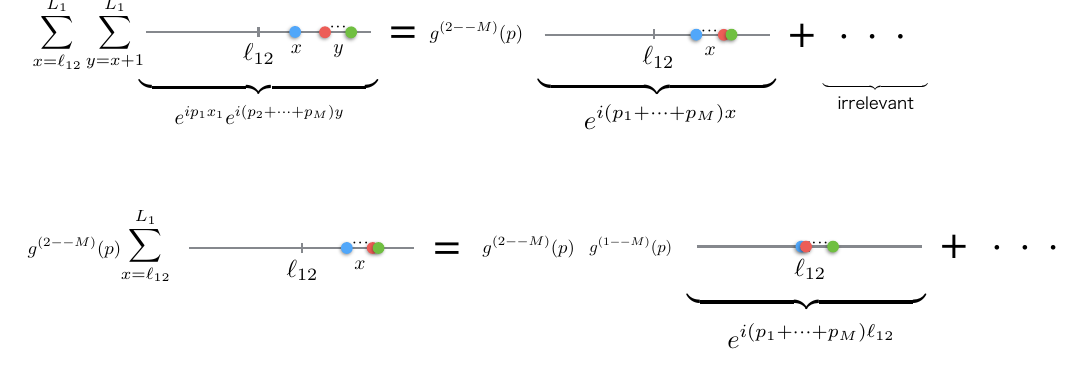
Figure 9 . We suppose that a magnon is located at the site x and the remaining M 1 magnons are (cid:0) located at the site y . Firstly, we sum over the position y . Then we obtain a geometric series such as g (2 (cid:0) M ) = 1 , and have the propagation factor e i ( p 1 + (cid:1)(cid:1)(cid:1) + p M x ) . Next, by summing e (cid:0) i ( p 2+ (cid:1)(cid:1)(cid:1) + pM ) 1 (cid:0) over the position x , we get the factor g (1 (cid:0) M ) = 1 . Therefore, the coe(cid:14)cient in front e (cid:0) i ( p 1+ (cid:1)(cid:1)(cid:1) + pM ) 1 (cid:0) of the bridge length propagation factor e i ( p 1 + (cid:1)(cid:1)(cid:1) + p M ) becomes the product for the geometric